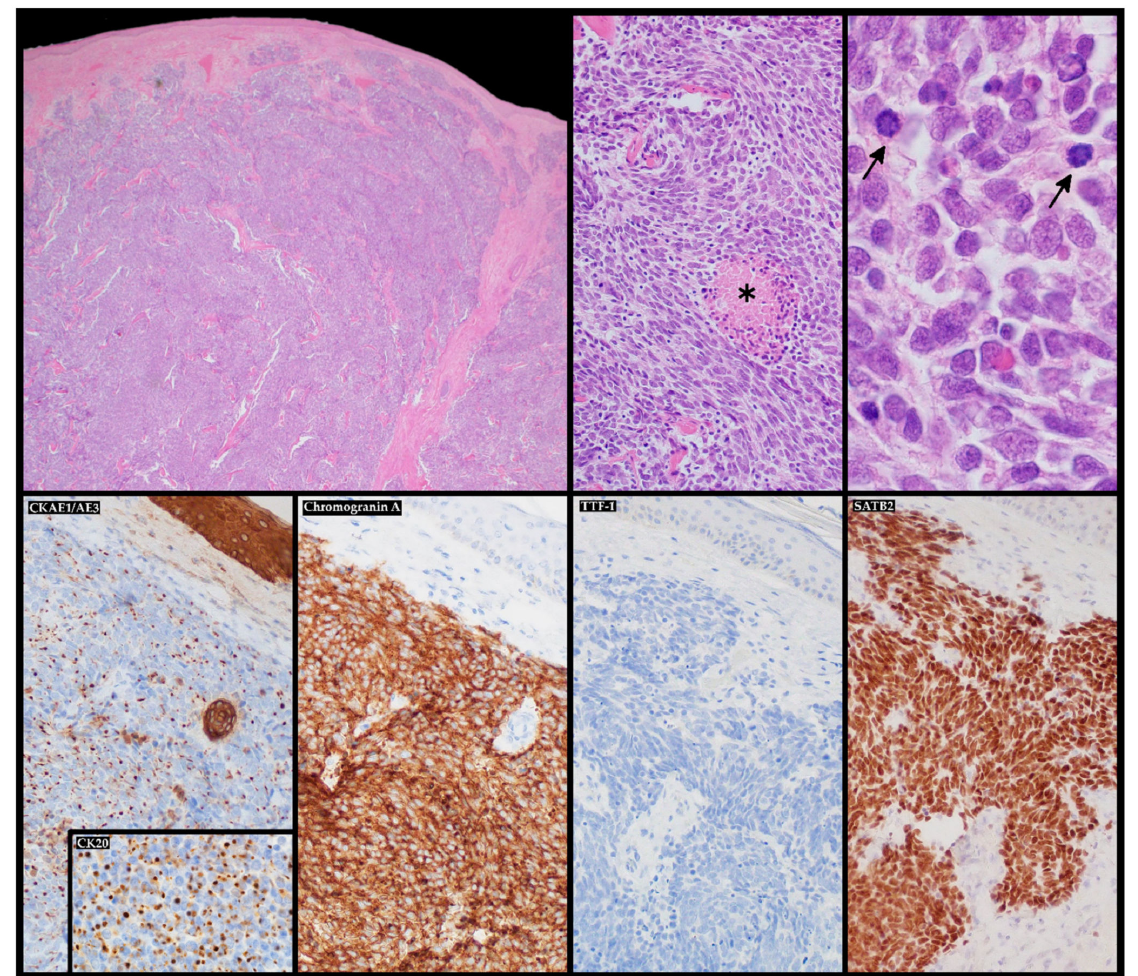
Figure 1. Merkel cell carcinoma histological features with its typical immunohistochemical profile (CK20+, CKAE1/AE3+, Chromogranin A+, SATB2+, and TTF-1-), focal necrosis (see: asterisk), and brisk mitotic activity (see: arrows). CK20— Keratin 20; CKAE1/AE3—Cytokeratin AE1/AE3—keratin cocktail that detects CK1—8, 10, 14–16 and 19, but does not detect CK17 or CK18; SATB2 Special AT-rich sequence-binding protein 2; TTF1—NK2 homeobox 1, also known as thyroid transcription factor